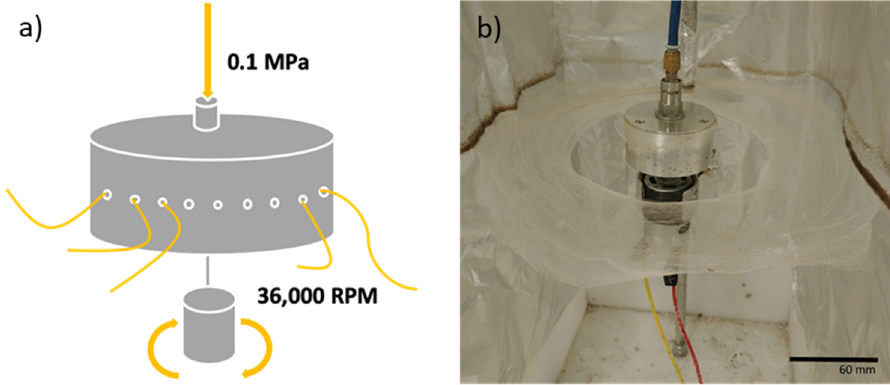
Figure 1. ( a ) diagrammatic representation of the pressurised gyration setup showing gas infusion pressure and maximum rotation speed used; fibres are formed as a product of the two acting forces ( b ) Photograph showing honey-PCL composite fibres surrounding the pressurised gyration vessel, ready to be